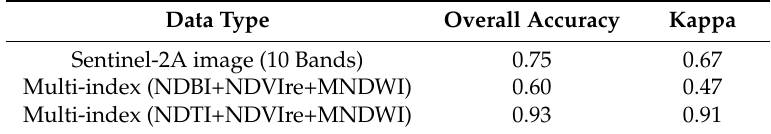
Table 5. Comparison of the overall accuracy and Kappa statistics for the Istanbul